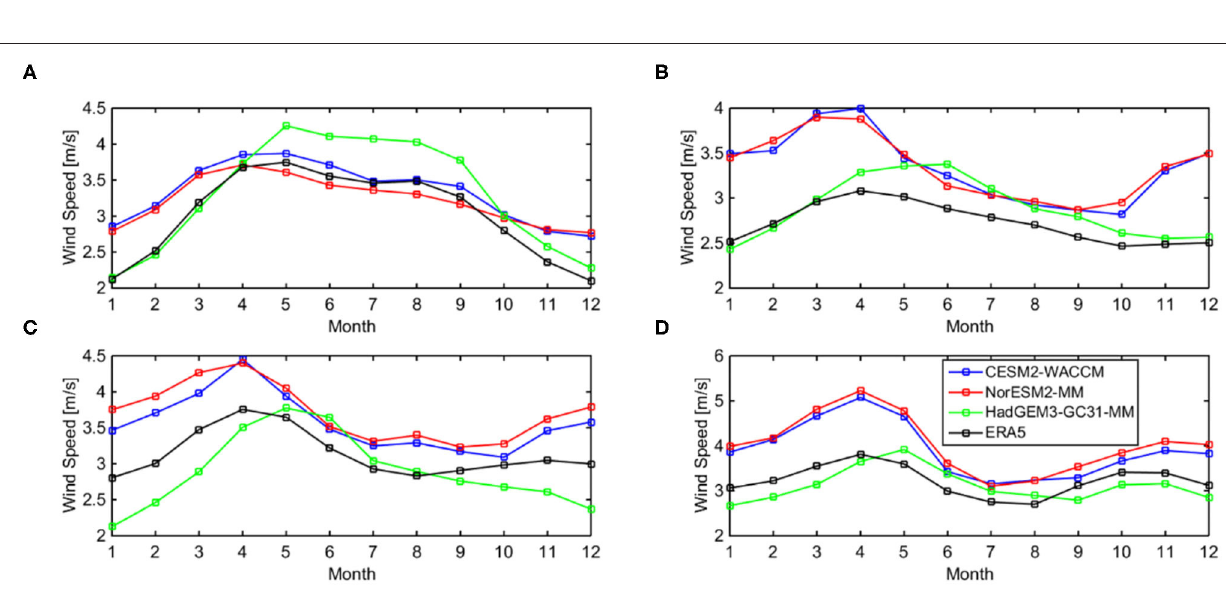
FIGURE 5 | Monthly mean 10-m wind speed (1986–2014) in CMIP6 and ERA5 (black line represents ERA5, and the blue, red, and green lines are the CESM2-WACCM, NorESM2-MM, and HadGEM3-GC31-MM, respectively). (A–D) Region I, region II, region III, and region IV, respectively.